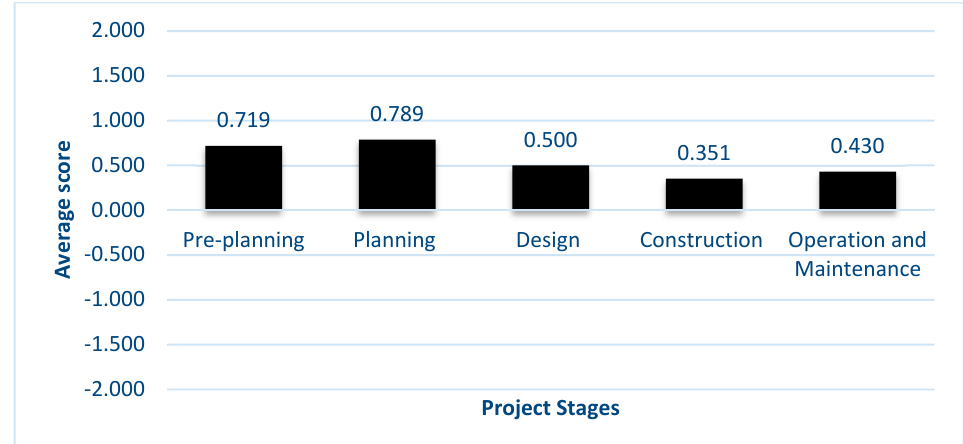
Figure 6. Benefit of GIS in various rail project stages.